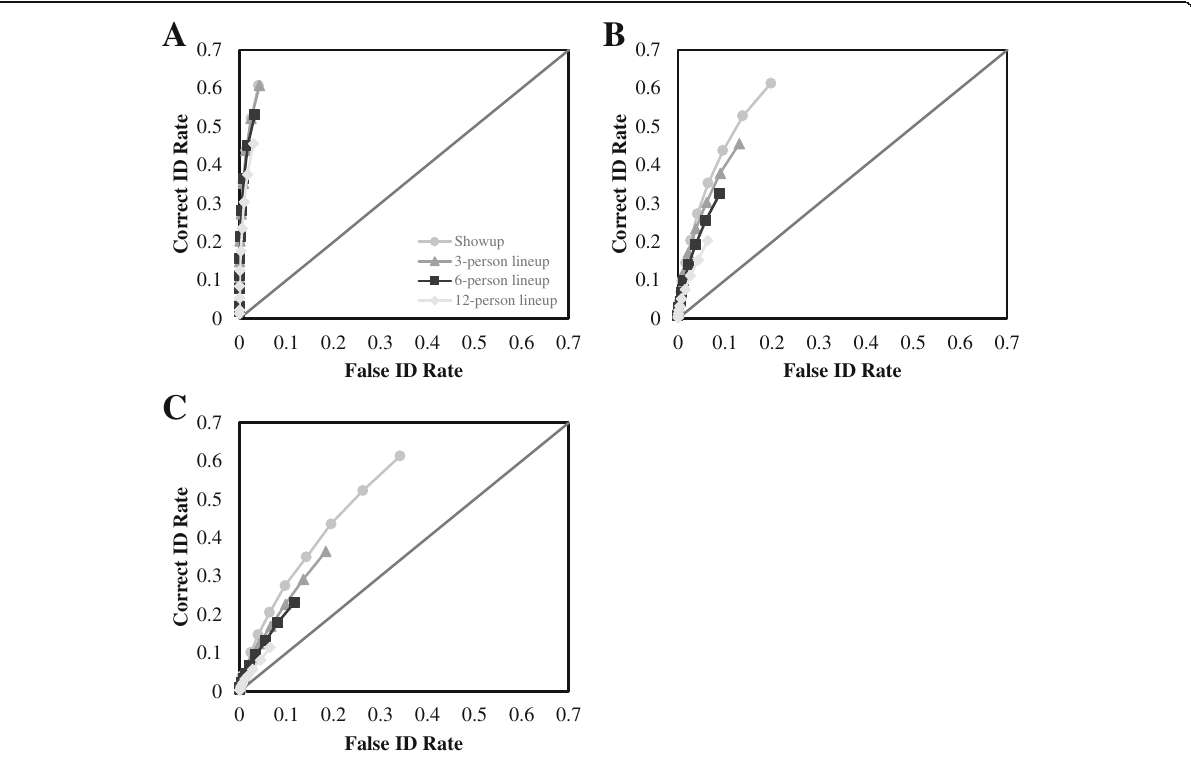
Fig. 3 Receiver operating characteristic (ROC) curves comparing showups, 3-, 6-, and 12-person fair sequential lineups. a SSP = SSF =.3, b SSP = SSF =.6, c SSP = SSF =.75. Encoding fixed at a =.3, and cseq = csu =.09. The solid diagonal line indicates chance performance. SSP Similarity of the innocent Suspect to the PERP, SSF Similarity of the Suspect to the Fillers, PERP